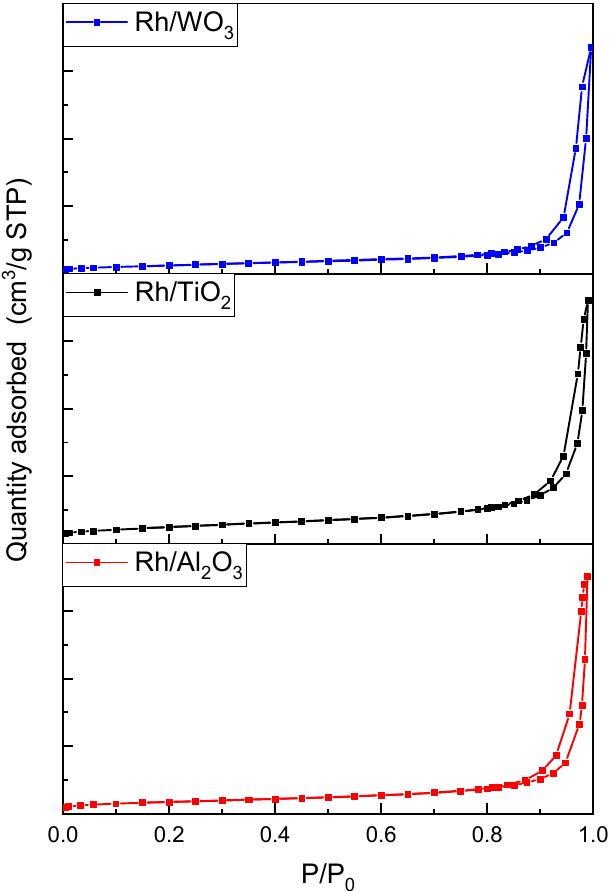
Figure 2. Nitrogen adsorption—Desorption isotherms, fresh samples. Reprinted with permission from Ref. [28]. Copyright 2021 IOSR Journals.